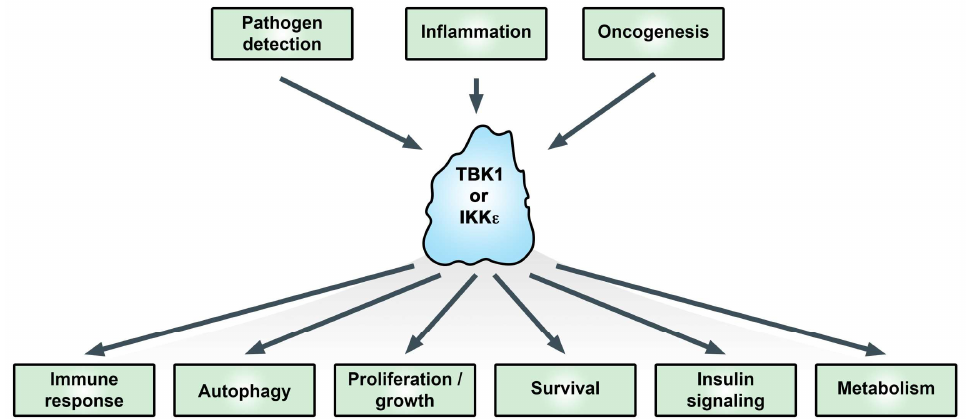
Figure 1. Functional effects of the IκB kinase (IKK)-related kinases. In addition to immune responses, IKKε and TANK-binding kinase 1 (TBK1) are important signaling proteins for critical cellular processes associated with cancer. For more information see text. Adapted from [19].